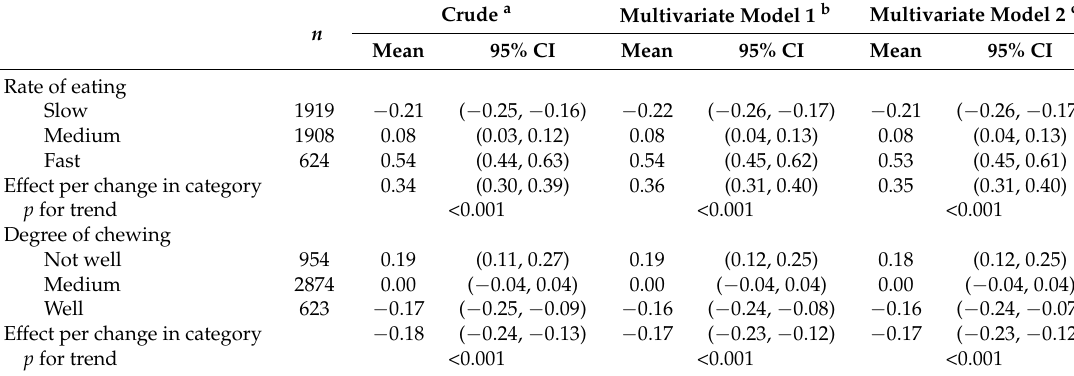
Table 2. Relationship of eating rate and degree of chewing with BMI z-score among Japanese preschool